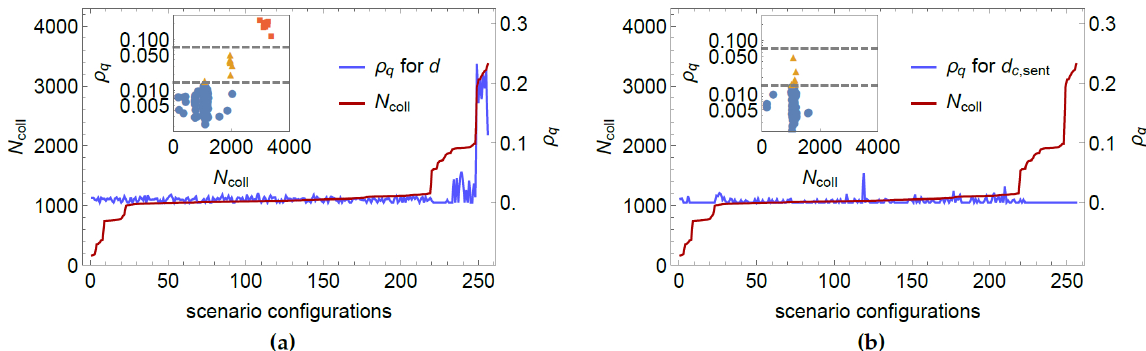
Figure 7. Ranked distribution of N coll (dark red, left y-axis). For the same cue configurations, the CCM distributions of ρ q (right y-axis) for ( a ) d and ( b ) d c , sent are shown in blue, respectively. The insets depict the corresponding scatter plots with data points representing weak (circles), moderate (triangles) and strong (squares) support for power law distribution; gray lines indicate the onsets of the different support classifications (similar to Figure